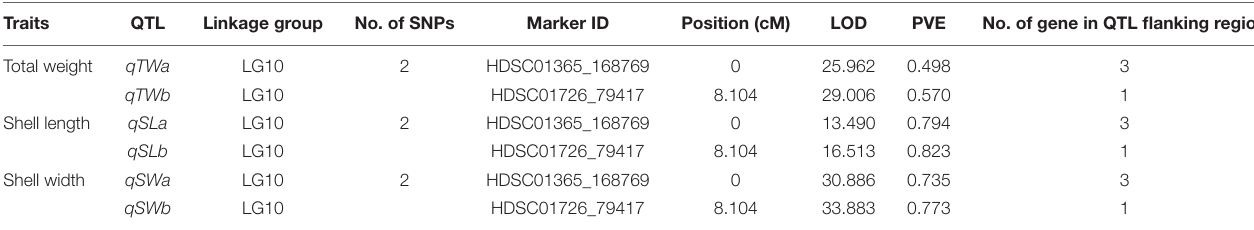
TABLE 7 | Summary of detected QTL for growth-related traits in Pacific